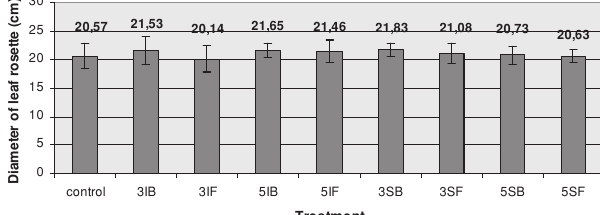
Figure 3. The effect of treatments on leaf rosette diameter of Saintpaulia ionantha (6 th February 2009)